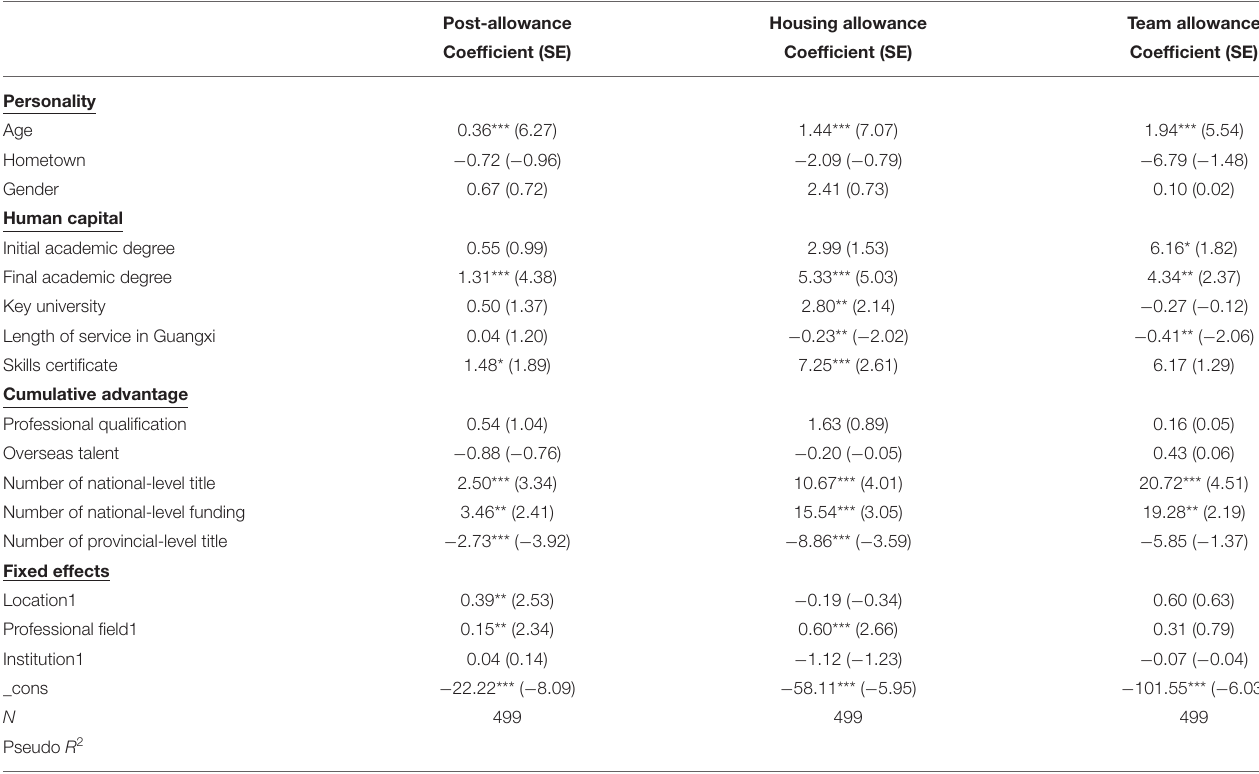
TABLE 4 | Regression results of different